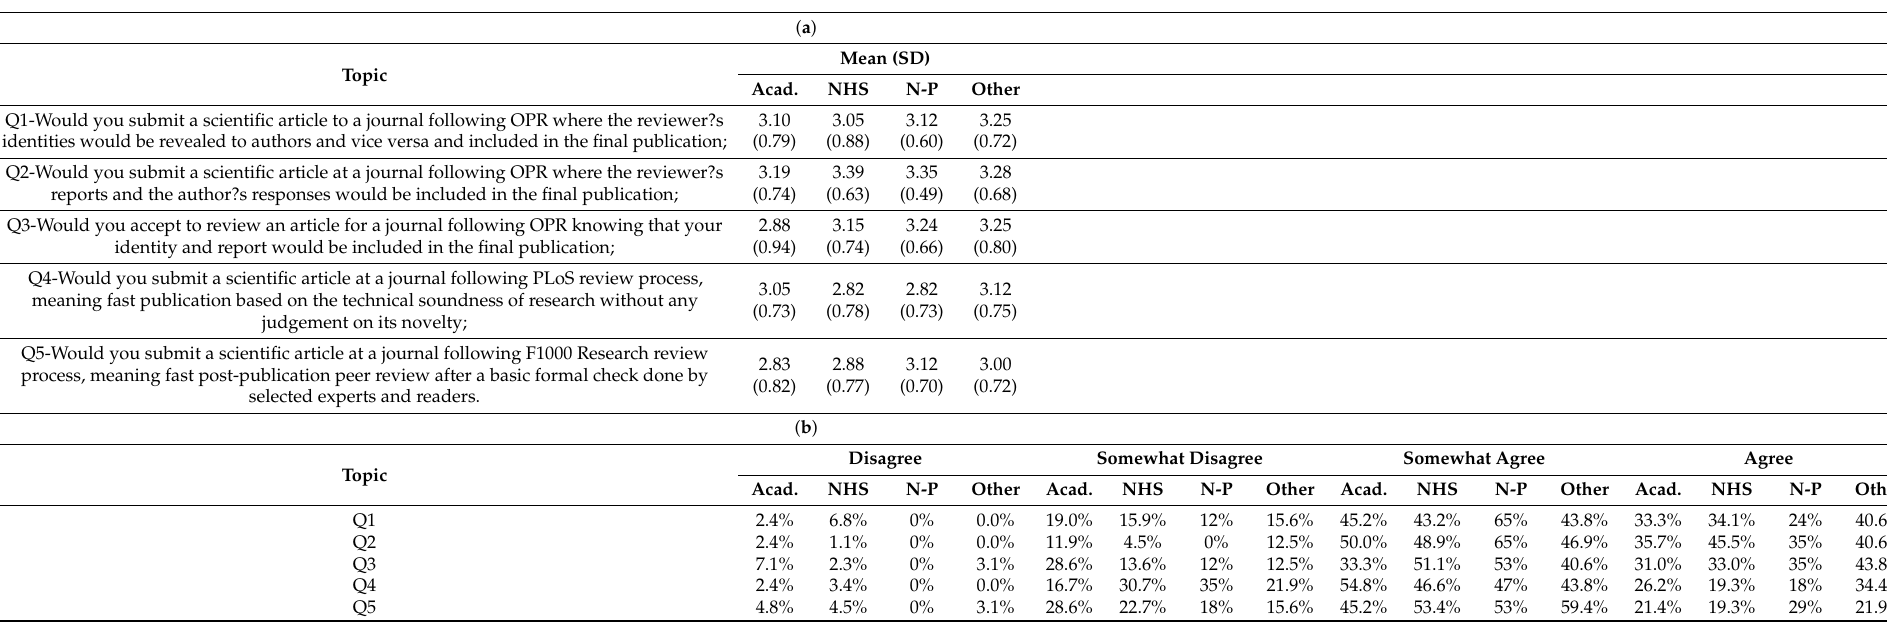
Table 7. ( a ) Define your position regarding Open Peer Review potentials-Mean and Standard Deviation per topic [Part 3, Q1 to Q5, professional category: Academic Doctors (Acad.), NHS Doctors (NHS), Nursing and Paramedical Staff (N-P), Other]; ( b ) Define your position regarding Open Peer Review potentials-Percentages per topic [Part 3, Q1 to Q5, professional category: Academic Doctors (Acad.), NHS Doctors (NHS), Nursing and Paramedical Staff (N-P), Other]. ( a ) Mean (SD) Topic Acad. NHS